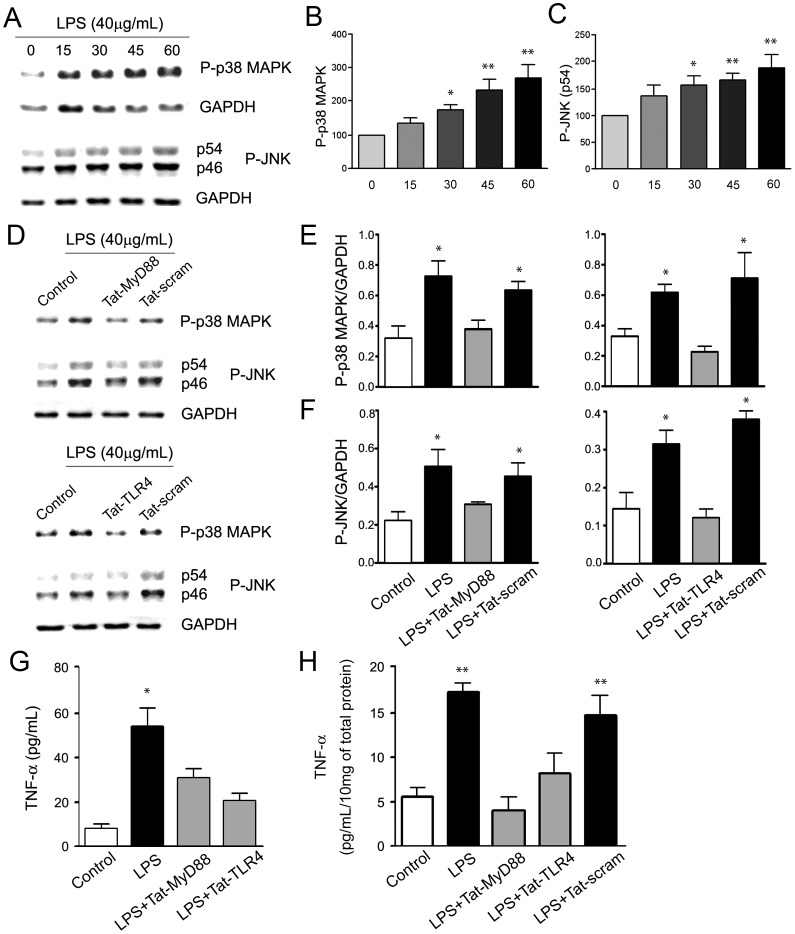
Time course of kinase activation and TNF-α formation following LPS treatment, and the inhibition by Tat-MyD88 and Tat-TLR4.A. Representative blots showing P-p38 MAPK and P-JNK rapidly increased in brain tissue following LPS treatment. GAPDH was monitored as a loading control. B,C. Quantification of the increased P-p38 MAPK and P-JNK levels over 60 minutes following LPS treatment. D-F. P-p38 MAP kinase and P-JNK increases from LPS were attenuated by Tat-MyD88 and Tat-TLR4. D. Representative blots of kinase activation following various treatments. E. Quantification of P-p38 MAPK normalized to GAPDH levels. F. Quantification of P-JNK normalized to GAPDH levels. G,H. LPS treatment increased TNF-α levels, and this increase was blocked by Tat-TLR4 and Tat-MyD88. Quantification of TNF-α levels using ELISA in acute brain slice (G) parallels results found in whole brain lysates of injected animals (H).